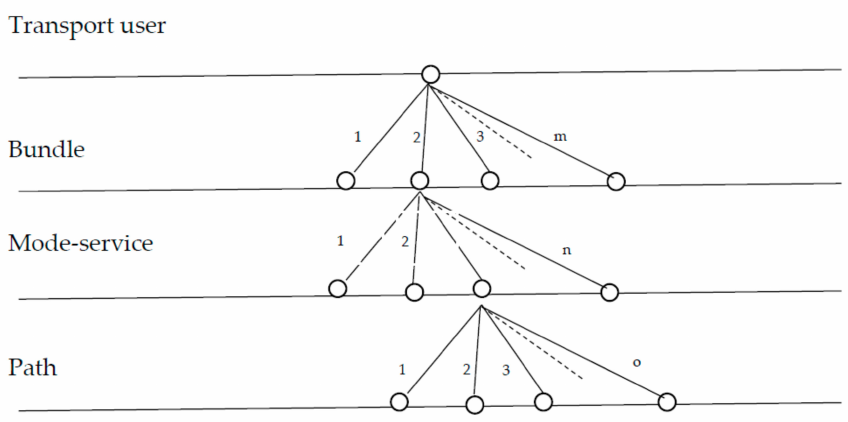
Figure 4. Example of travel choices tree in